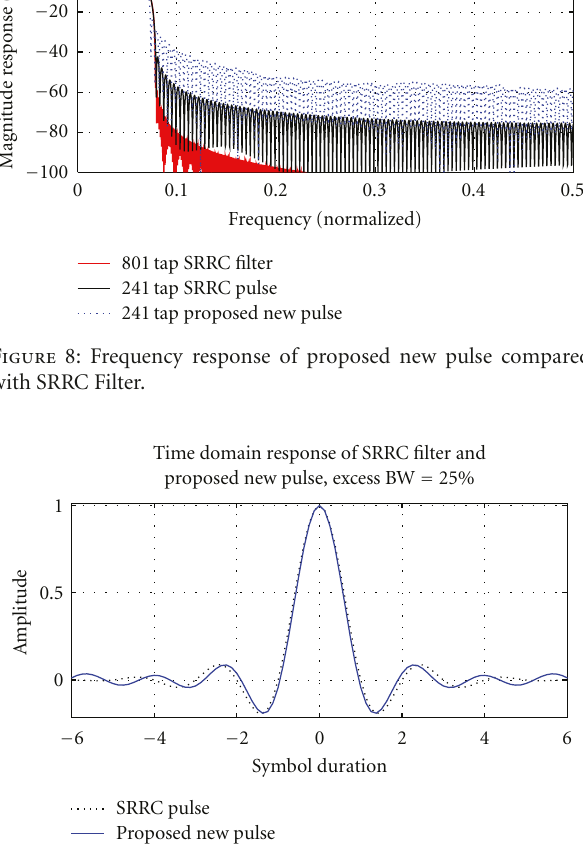
Figure 9: Time response of proposed new pulse compared with SRRC